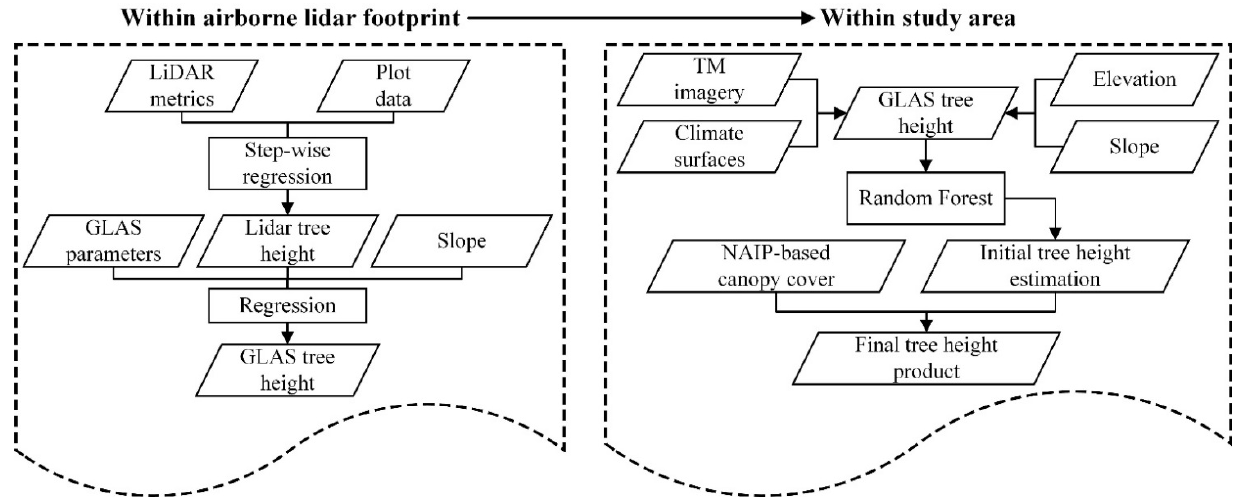
Figure 3. The procedure of estimating forest tree height in the study area through the combination of multi-source